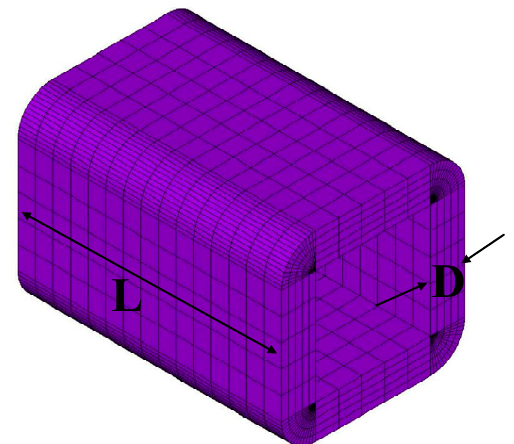
Figure 7. Three-dimensional simulation model of the excitation coil.